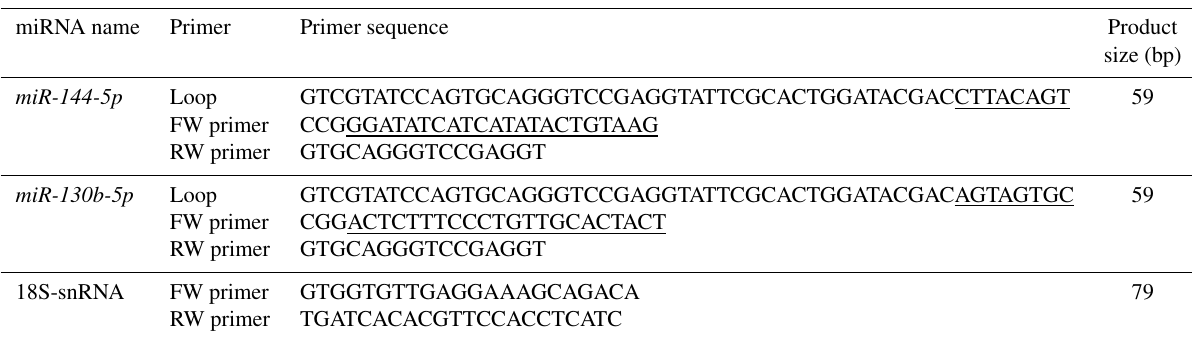
Table 1. The primer sequences of the stem-loop qPCR